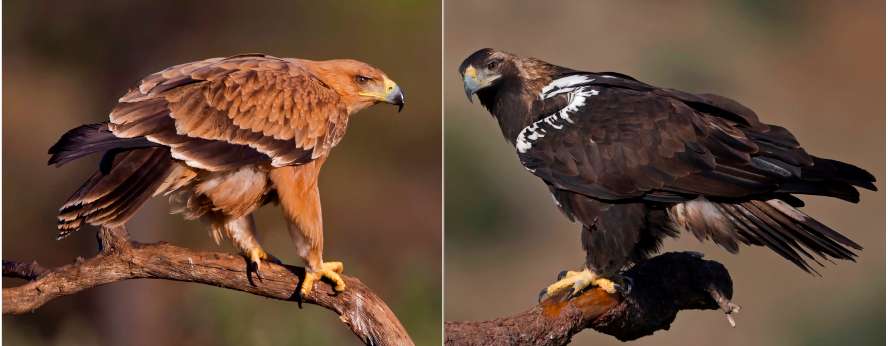
Figure 1. Spanish Imperial Eagles Aquila adalberti . On the left, a juvenile individual showing a light-colored plumage mainly based on the presence of pheomelanin. On the right, an individual showing the much darker full adult plumage (with white “shoulders”), based on eumelanin. This eagle species presents delayed plumage maturation, and the adult plumage is typically attained when individuals are 4 years old. Photographs by Stewart Finlayson, Gibraltar Museum.